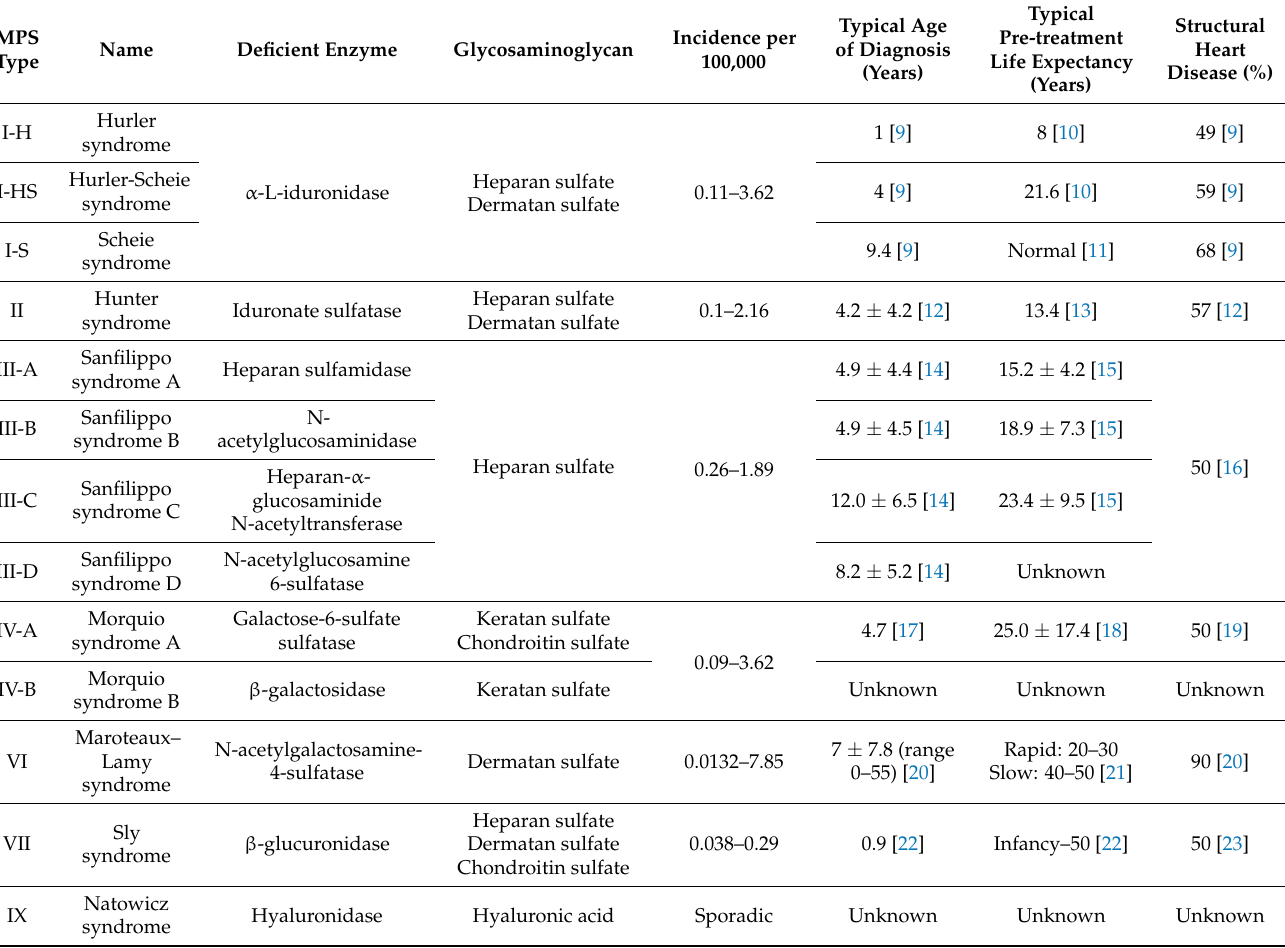
Table 1. Overview of types of mucopolysaccharidoses. Incidence figures compiled